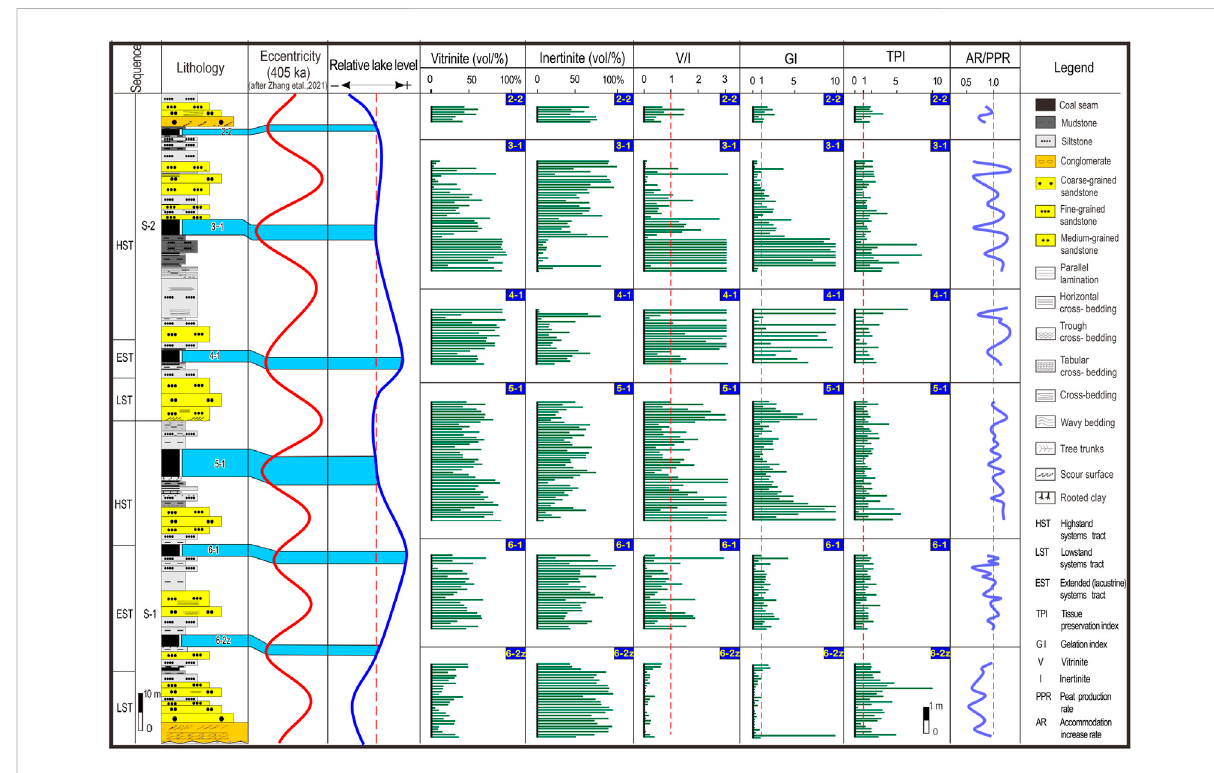
FIGURE 10 Relationship between sequence stratigraphy, occurrences of coal seams, maceral, and the astronomical 405-ka (eccentricity) cycle for the Yan ’ an Formation in the study